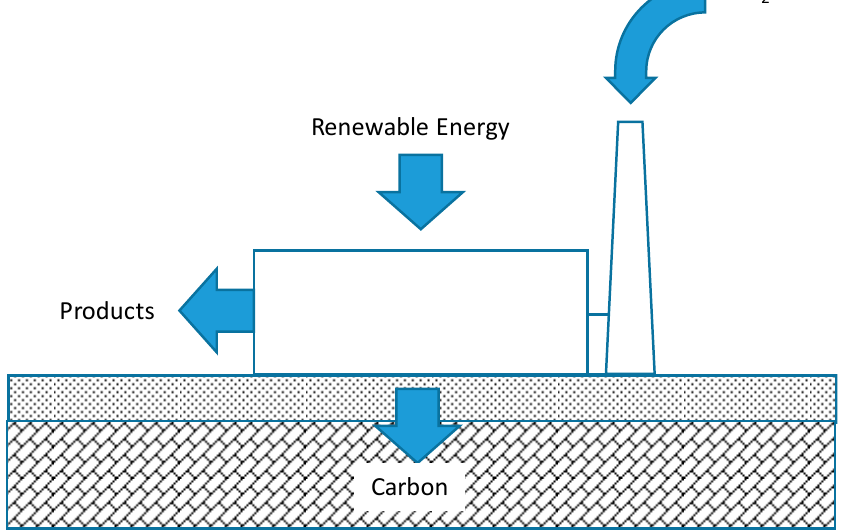
Figure 1. Carbon negative energy reverses the flow of carbon between lithosphere and atmosphere in production of energy for society, powered by renewable energy.